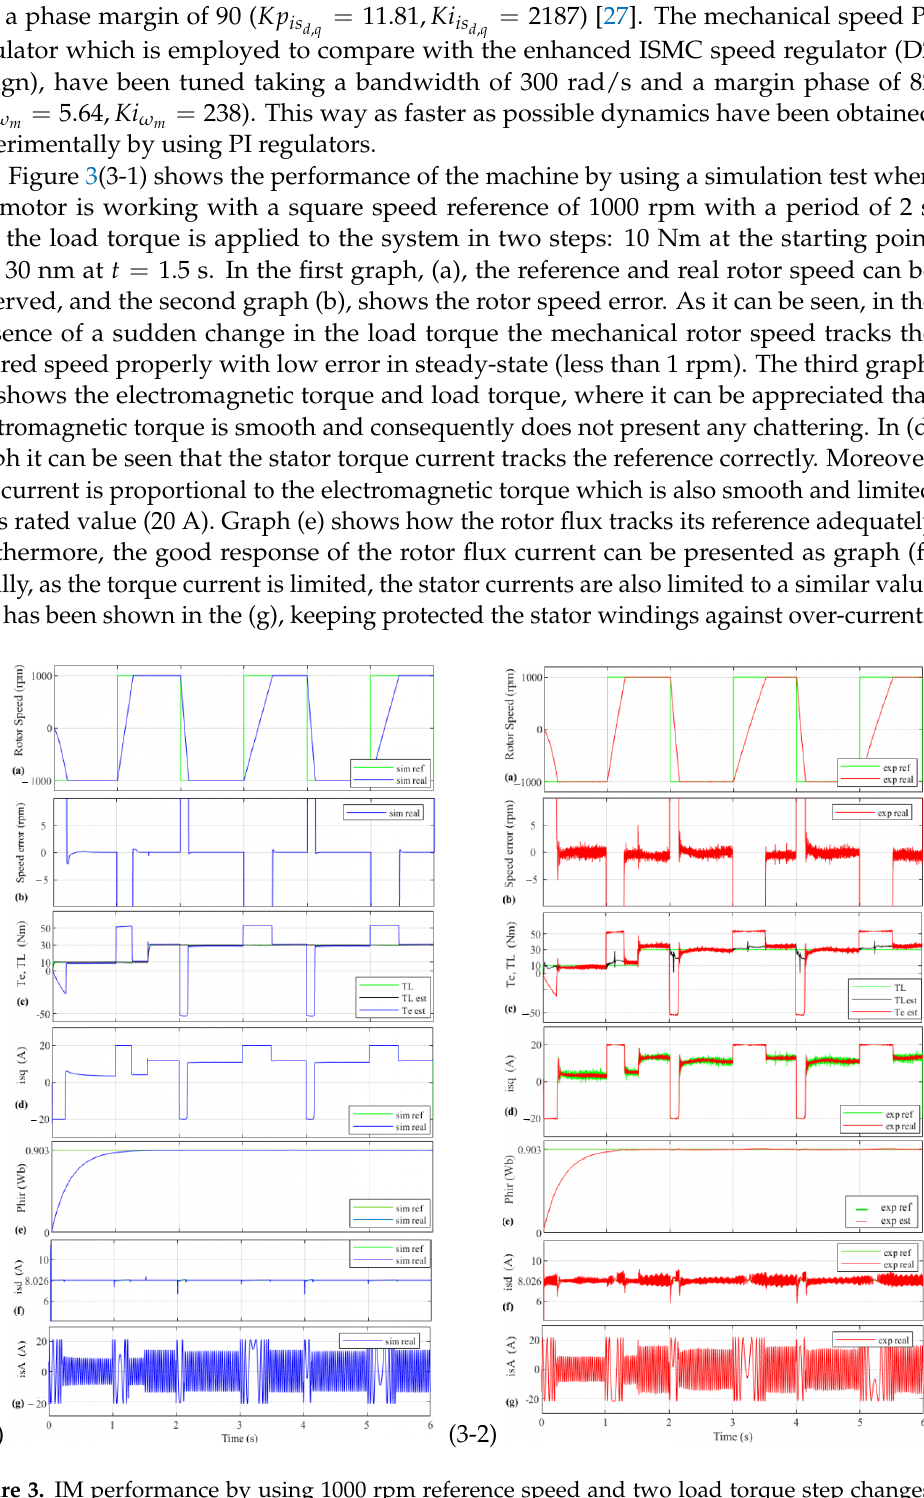
Figure 3. IM performance by using 1000 rpm reference speed and two load torque step changes: ( 3-1 ) simulation and ( 3-2 ) experimental (D2 design): ( a ) Rotor speed; ( b ) Speed error; ( c ) T e , T L ; ( d ) Torque current; ( e ) Rotor flux; ( f ) Rotor flux current and ( g ) Stator